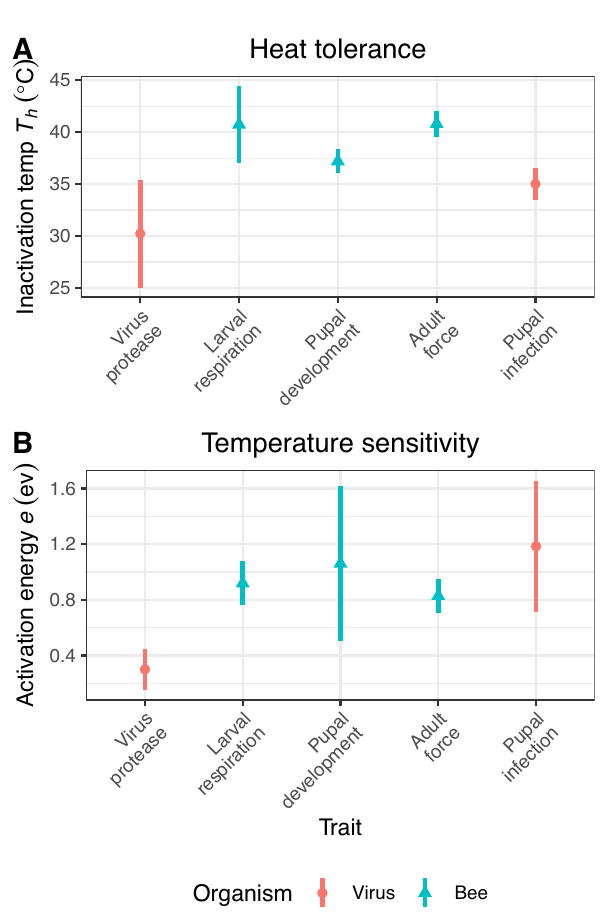
Fig. 2 Heat tolerance and temperature responsiveness of virus protease and bee traits. A Temperatures of 50% inactivation ( T h ) and B activation energies ( e ) for temperature sensitivity of virus protease (red circles) and bee traits (blue triangles) from Sharpe – School fi eld models depicted in Fig. 1. Points and error bars show model estimates ±2 standard